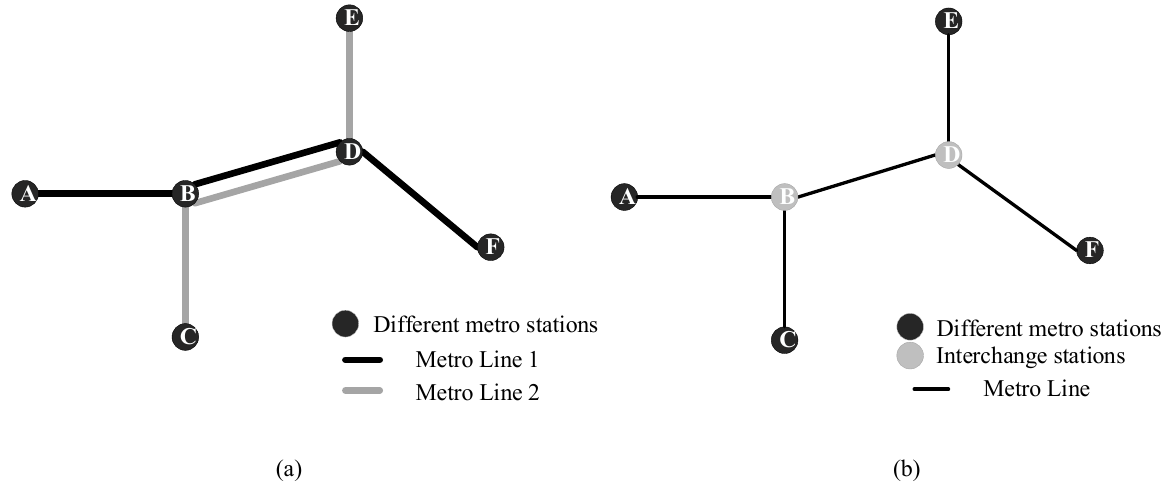
Figure 1. Mathematical representation of stations and lines: ( a ) Metro stations and lines, ( b ) topology diagram corresponding to metro stations and lines.